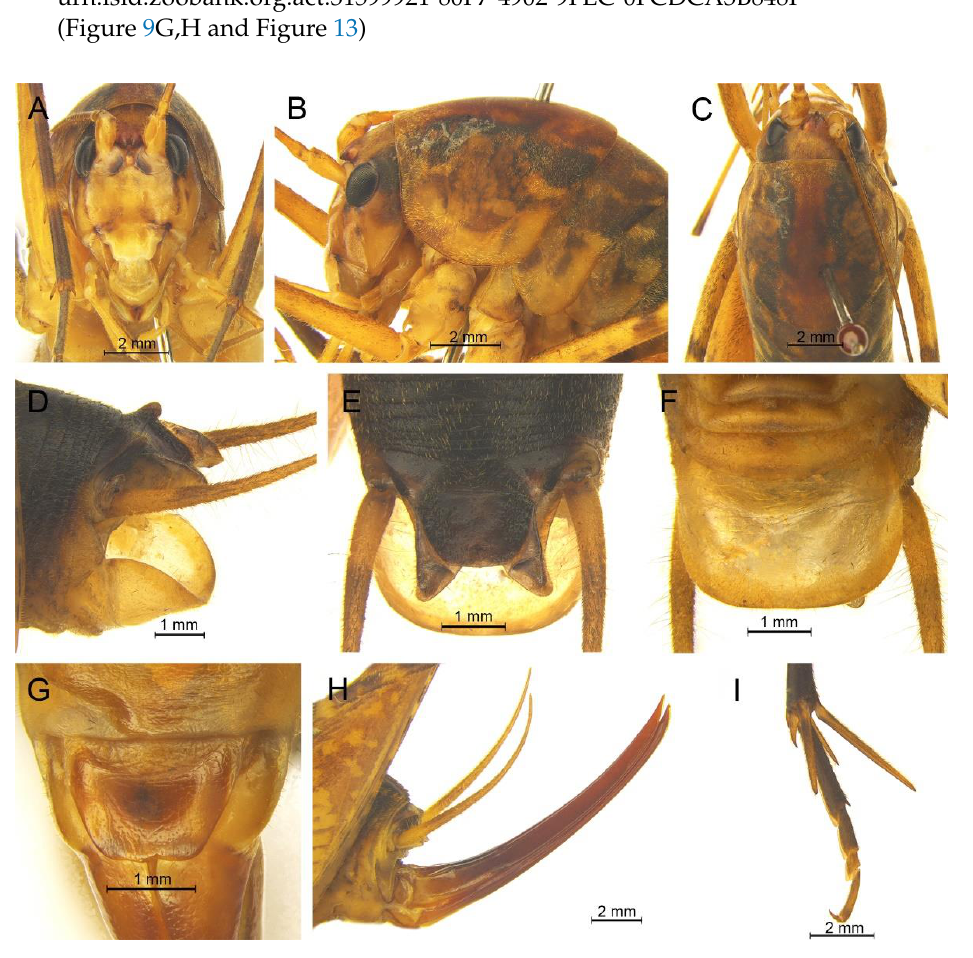
Figure 13. Pseudotachycines nephrus Zhu & Shi sp. nov., male: ( A – C ) head and pronotum: ( A ) frontal view, ( B ) lateral view, ( C ) dorsal view; ( D – F ) apex of abdomen: ( D ) lateral view, ( E ) dorsal view, ( F ) ventral view; ( I ) hind tarsus in lateral view; female: ( G ) subgenital plate in ventral view; ( H ) ovipos- itor in lateral view.